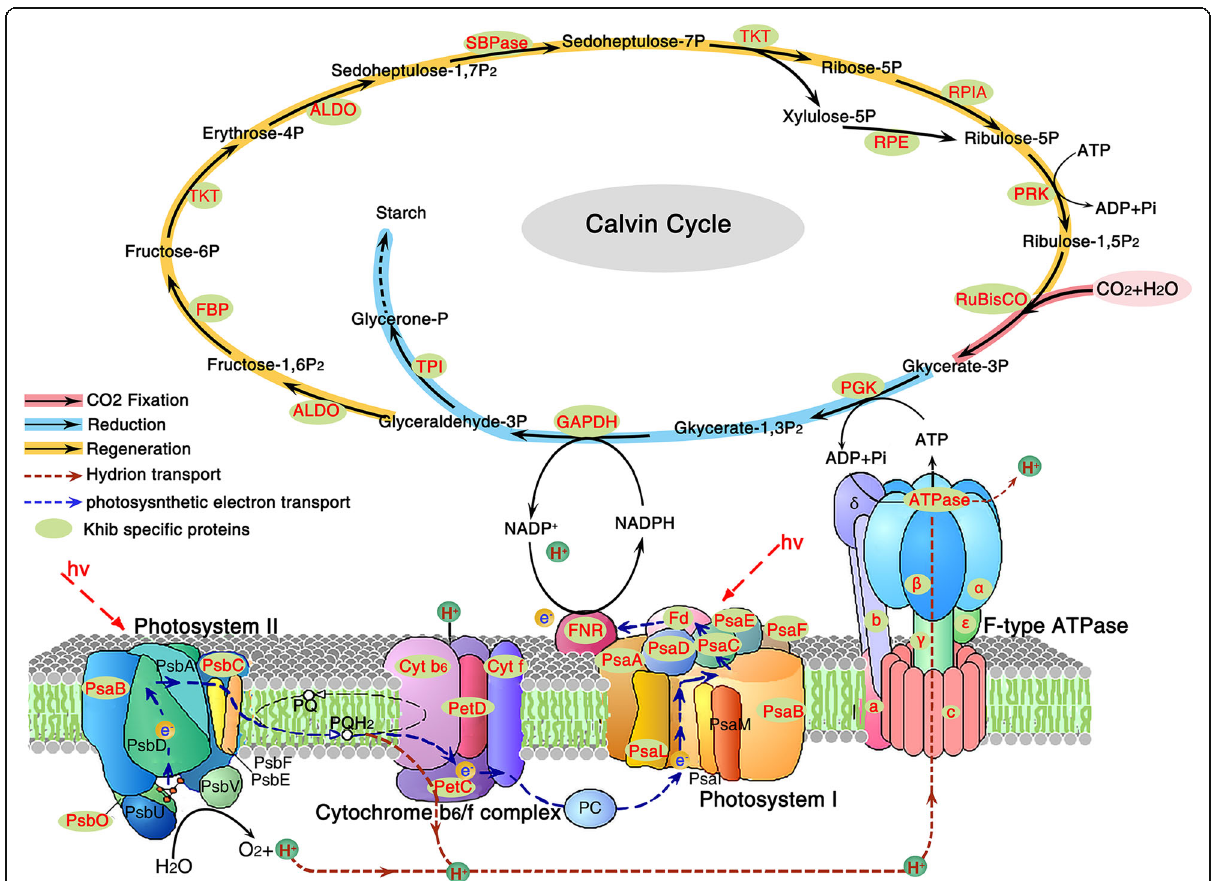
Fig. 5 Khib proteins enriched in carbon metabolism and photosynthesis pathways in rice. The 2-hydroxyisobutyrylated enzymes or proteins identified are highlighted in